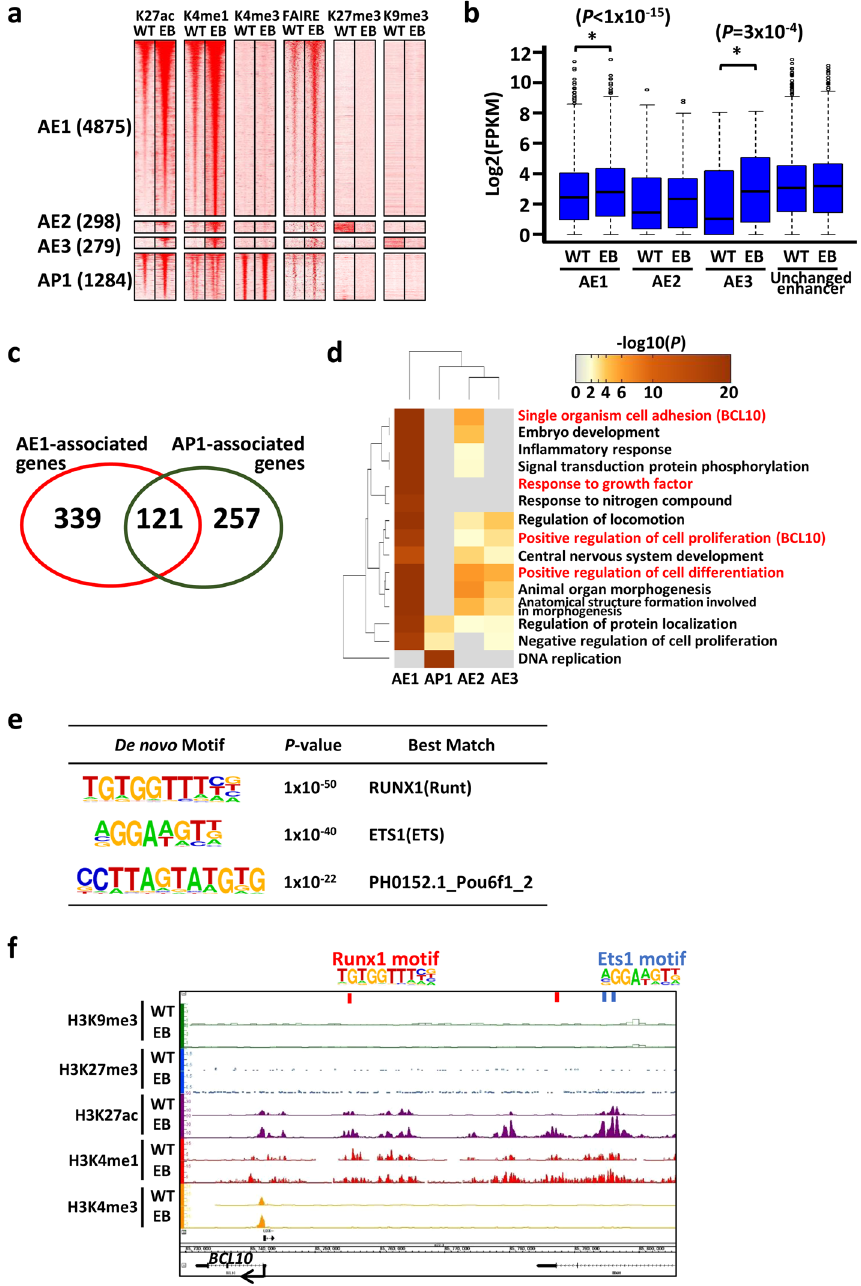
Figure 2. Epigenetic activation of enhancers and promoters in EBV-infected MKN7 cells. WT , MKN7 without EBV infection. EB , EBV-infected MKN7 cells. ( a ) Heatmaps representing read densities of H3K27ac, H3K4me1, H3K4me3, FAIRE, H3K27me3, and H3K9me3 in ± 5-kb regions centred on activated enhancers and promoters. AE1, AE2, and AE3 are subgroups of activated enhancers in E1, E3, and E5, respectively. AP1 is subgroup of activated promoters without repressive histone modification. ( b ) Expression levels of genes nearest to each activated enhancer and H3K27ac unchanged enhancers. Genes were significantly upregulated in EBV-infected GC cells in AE1 ( P < 1 × 10 − 15 : calculated by paired t -test) and AE3 ( P = 3 × 10 − 4 : calculated by paired t-test). ( c ) Overlap of AE1-associated genes ( red ) and AP1-associated genes ( green ). This Venn diagram showed that as many as 339 genes were upregulated by enhancer activation without increase of H3K27ac at promoter. ( d ) GO enrichment analysis of genes with enhancer or promoter activation. Colour scale represents binomial P - values (in − log 10 scale). While genes associated with “DNA replication” are preferentially regulated by promoter activation, those associated with “cell adhesion”, “proliferation”, and “differentiation” are preferentially regulated by enhancer activation. ( e ) Enriched known motif at open chromatin region detected by FAIRE-seq overlapped with AE1. ( f ) Histone modification and position of enriched motifs around the representative activated gene, BCL10